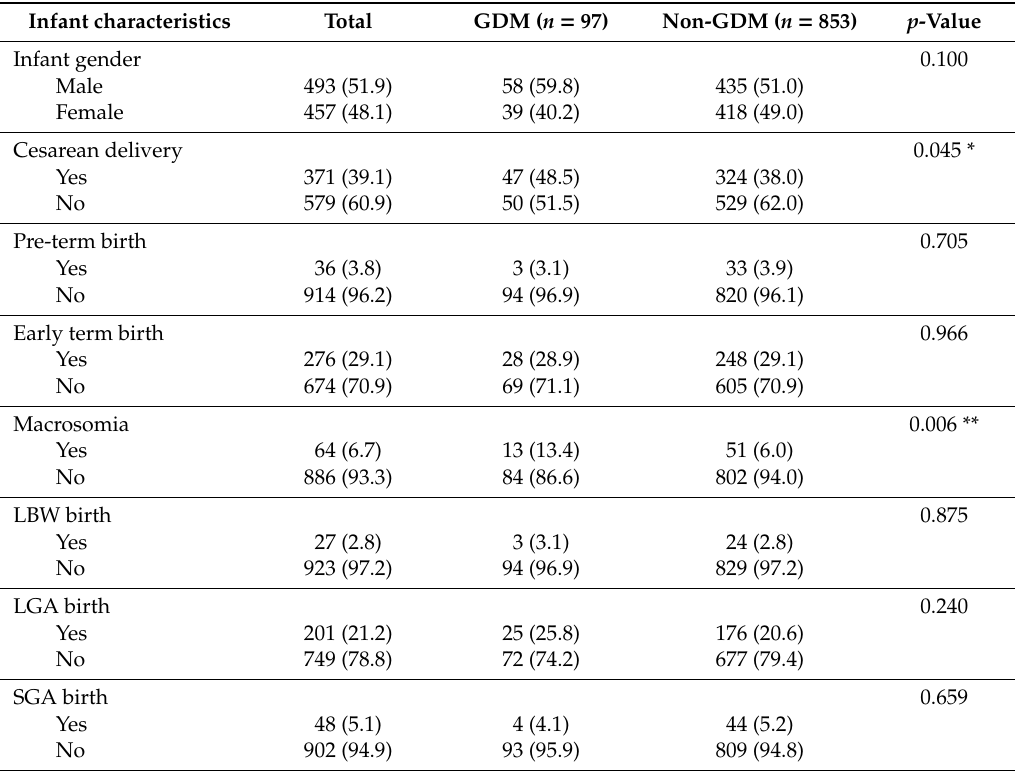
Table 2. Comparisons of infant characteristics between groups of gestational diabetes mellitus (GDM) and non-GDM in the cohort ( n =